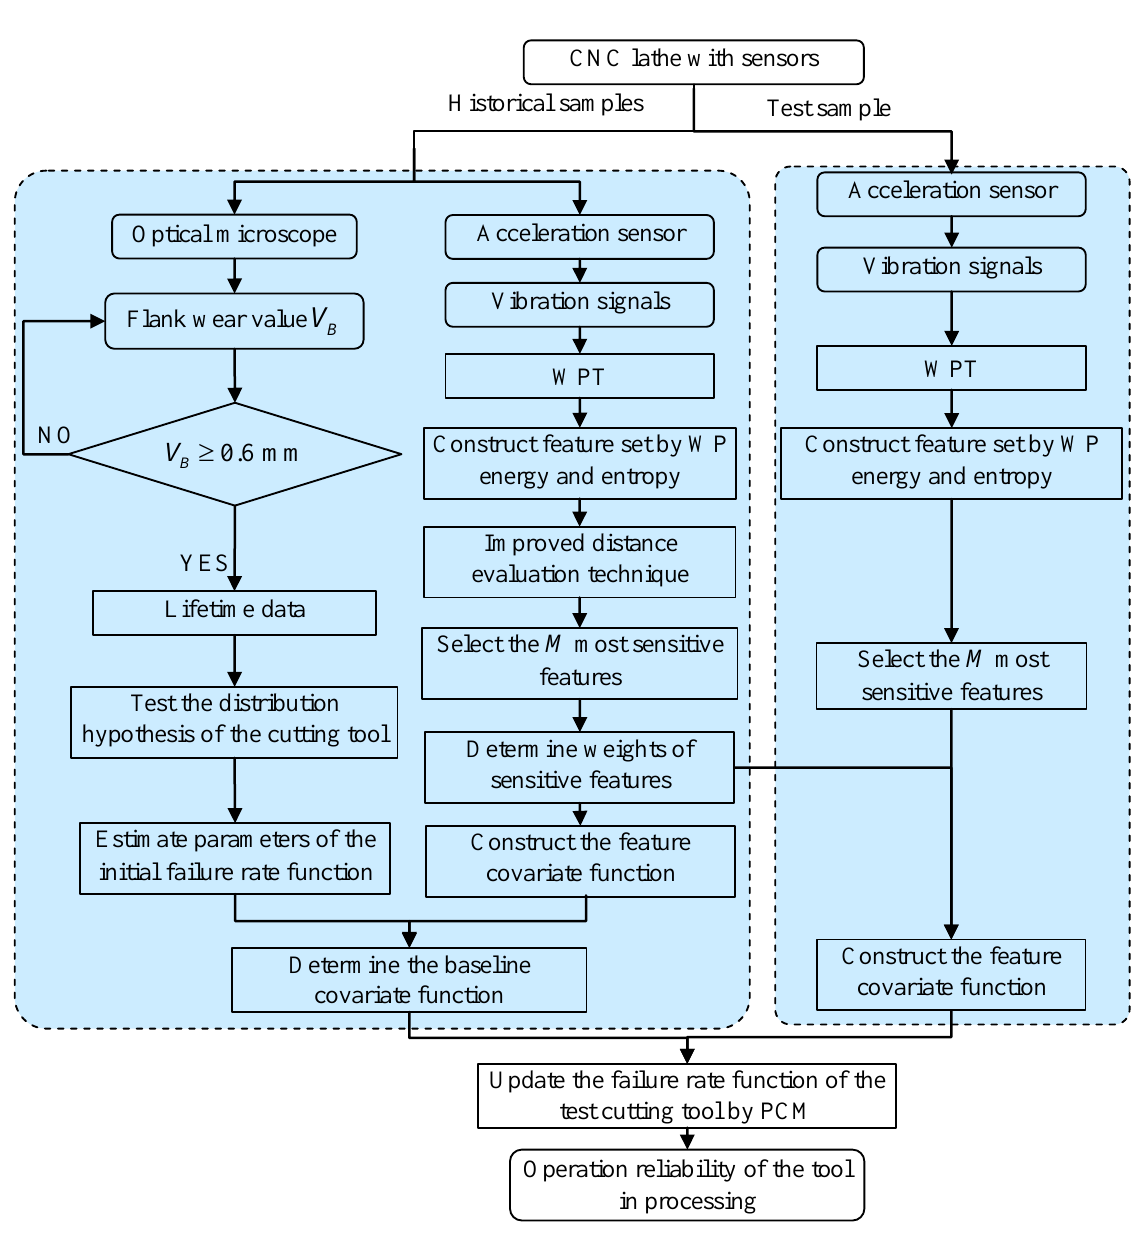
Figure 1. Flowchart of the proposed